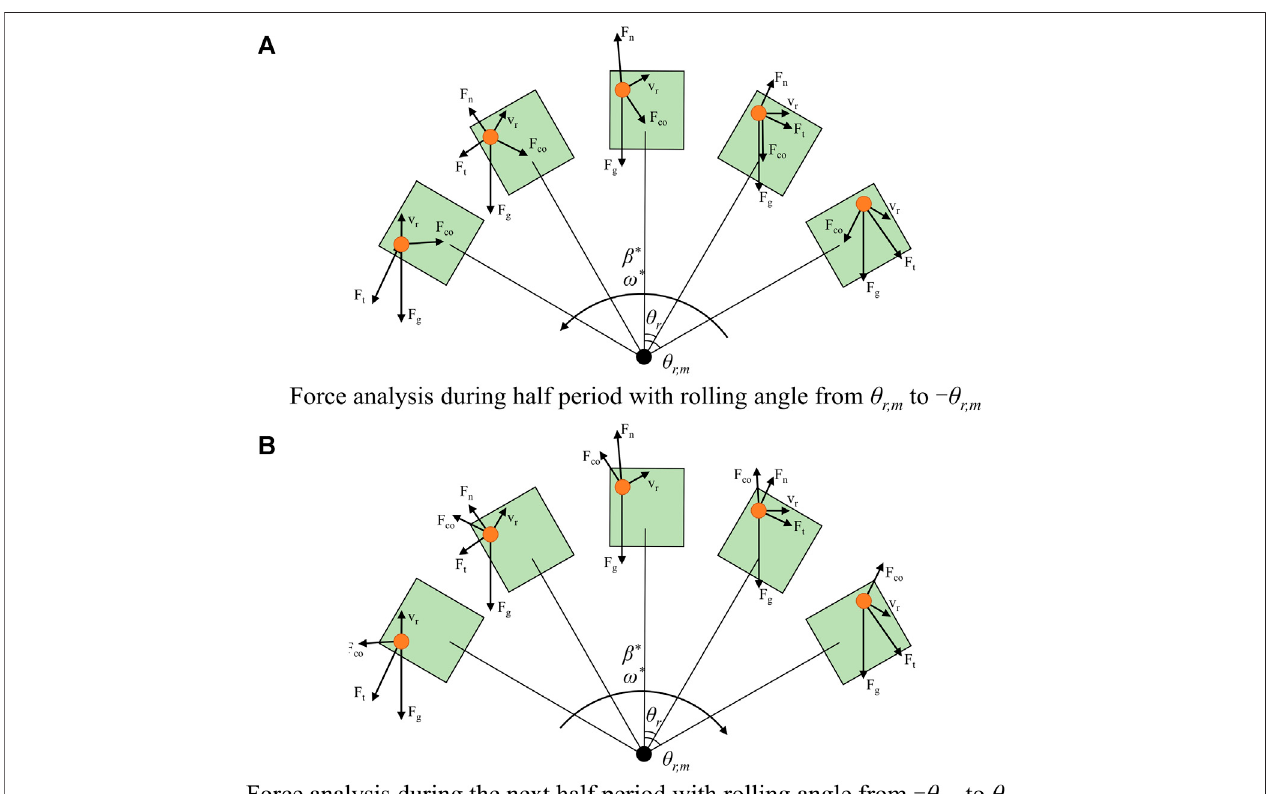
FIGURE 1 | Schematic diagram of rolling condition and additional inertial